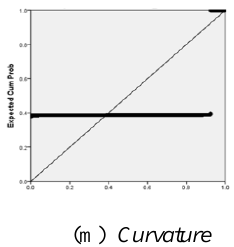
Figure 6 Results of linearity